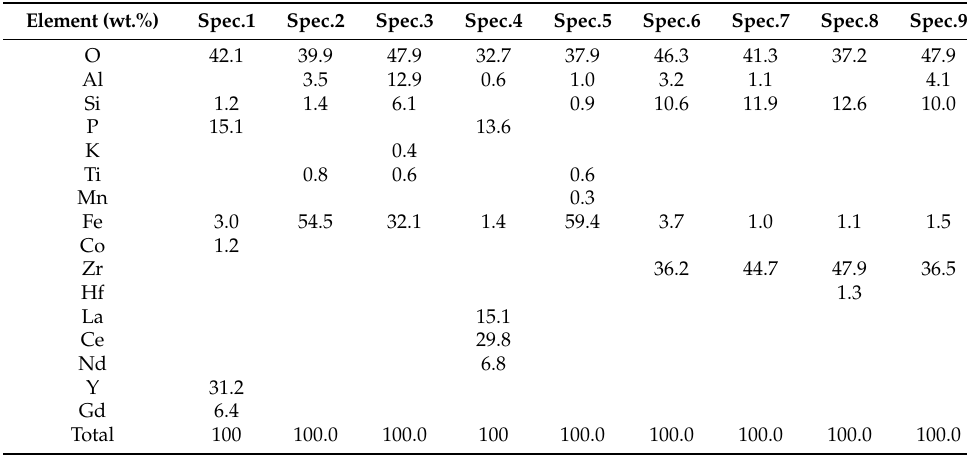
Table 8. Results of chemical analysis of points (sample 243, Figure 12). Element